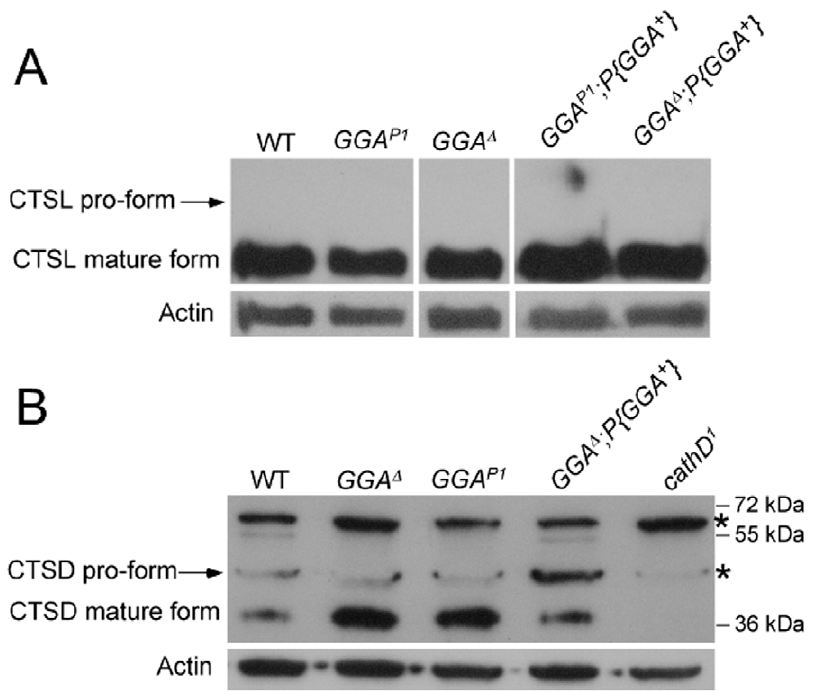
Figure 5. Cathepsin L and cathepsin D processing and steady-state levels are not impaired in GGA null flies. A. Western blot showing mature CTSL protein level relative to cytoplasmic actin in adult wild-type (WT), GGA P1 , GGA D , GGA P1 ;P{GGA + } and GGA D ;P{GGA + } rescue flies. The unprocessed form of CTSL is undetectable across all the samples. Actin levels from corresponding samples are shown below. B. Western blot showing mature CTSD protein level relative to cytoplasmic actin in adult wild-type (WT), GGA D , GGA P1 , GGA D ;P{GGA + } and cathepsin D null mutant flies ( cathD 1 ) [37]. The CTSD pro-form comigrates with a cross-reactive antigen also present in CTSD null mutant (asterisk). An antigen of ca. 63 kDa also appears in all samples, but since this antigen is also present in cathD 1 flies (asterisk), it is unrelated to CTSD. Actin levels from corresponding lanes are shown below. All images using a given antibody were taken from the same blot at the same exposure.